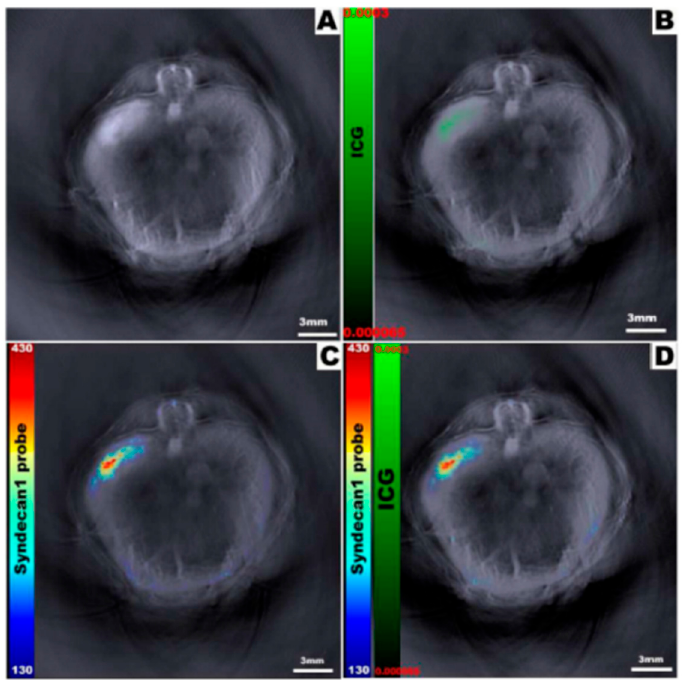
Figure 5. The ability to view multiple dyes in a single animal simultaneously is demonstrated. ( A ) no exogenous contrast agent ( B ) Image with only ICG ( C ) Image with only CF-750 probe ( D ) Image with both ICG and CF-750 Figure from [67] reproduced with permission from the publisher.